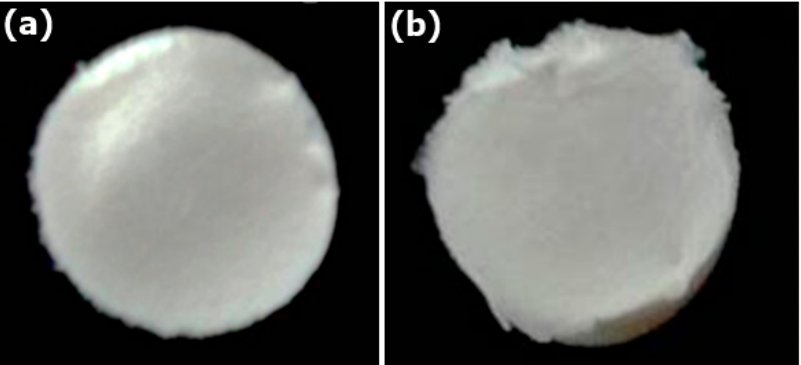
Figure 5. Optical images of the ( a ) COL scaffold and ( b ) COL-HANF scaffold.